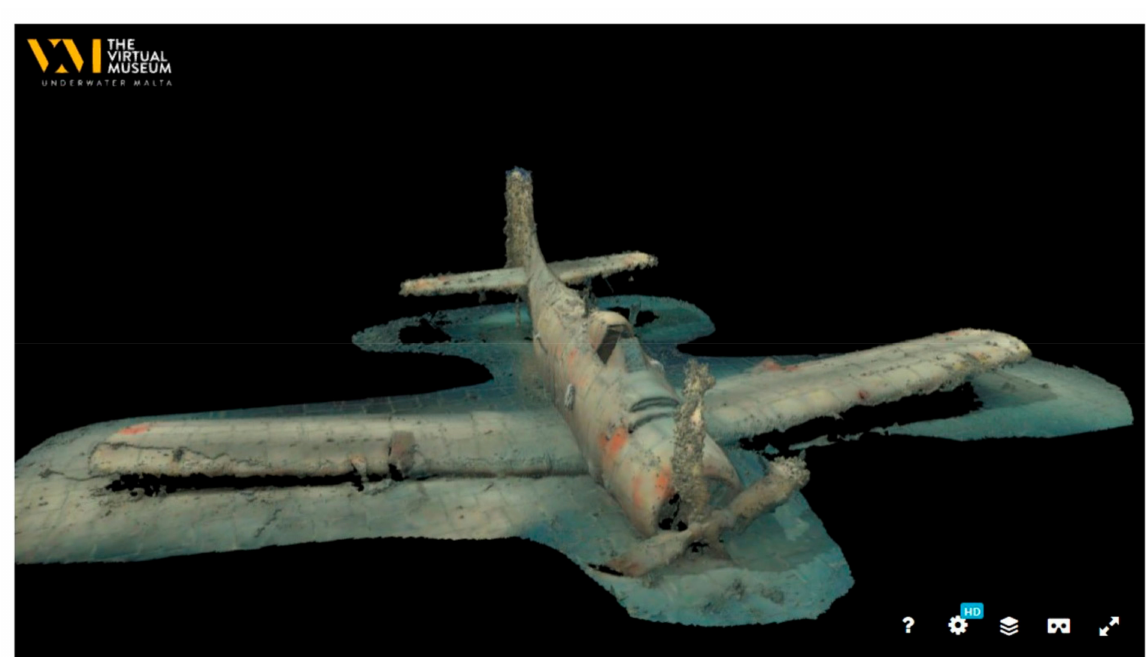
Figure 10. Example of the textured model of the Douglas A1-Skyraider on Sketchfab.